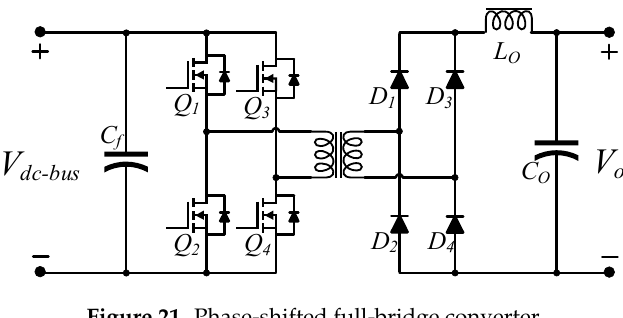
Figure 21 . Phase-shifted full-bridge converter. Figure 21. Phase-shifted full-bridge converter.